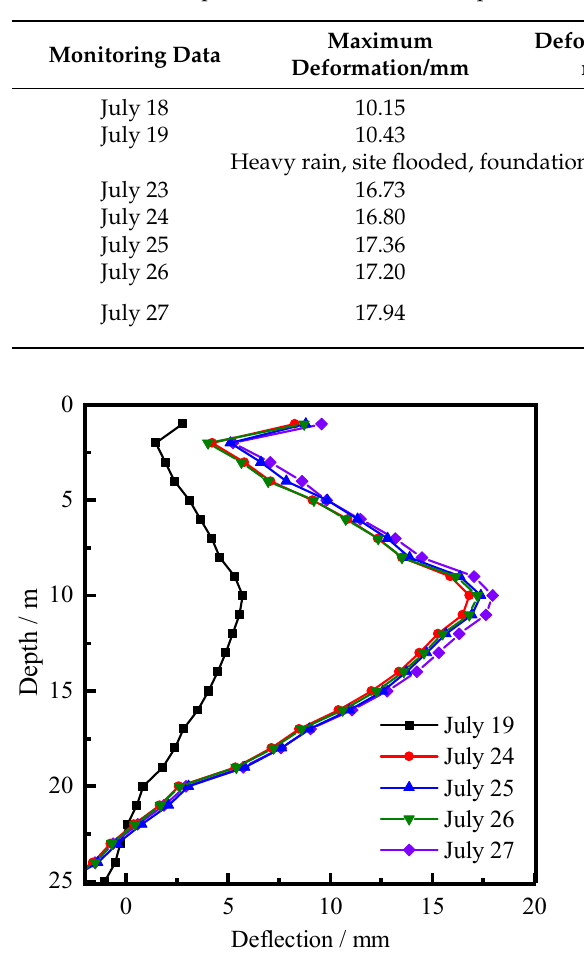
Table 1. Lateral displacement increment of the pile before and after the rainstorm.